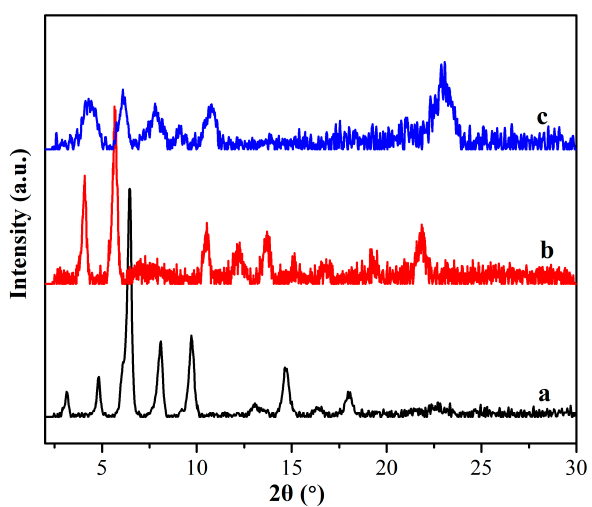
Figure 7. X-ray diffraction patterns of xerogels from gels in n-pentanol: ( a ) TC16-Ben; ( b ) TC16-Np; ( c ) TC16-Fl.